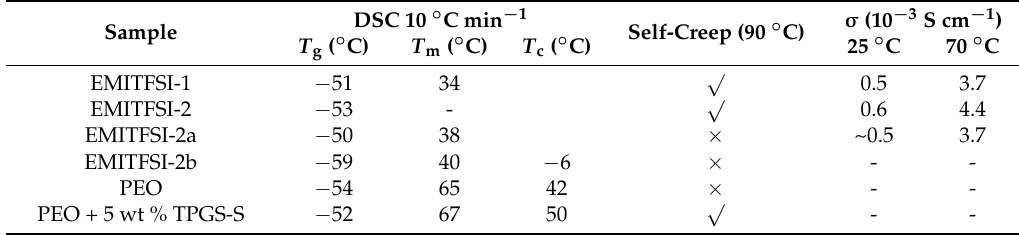
Table 2. Physicochemical characterization of PEO, PEO + 5 wt % TPGS-S, and the electrolytes. Transition temperatures T g , T c , and T m , as measured by DSC, a result of the self-creep test at 90 °C and ionic conductivity (σ).